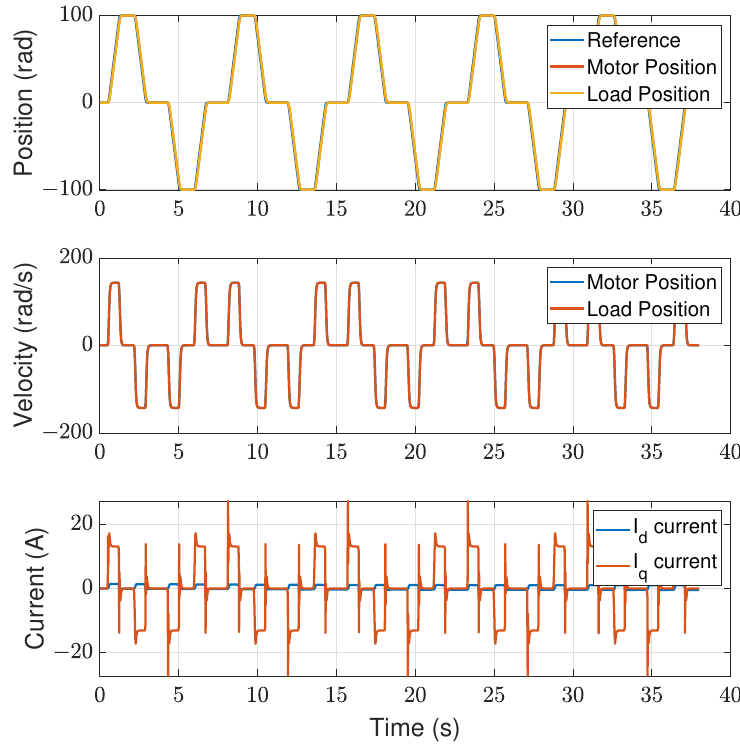
Figure 8. Controlperformance with the backlash